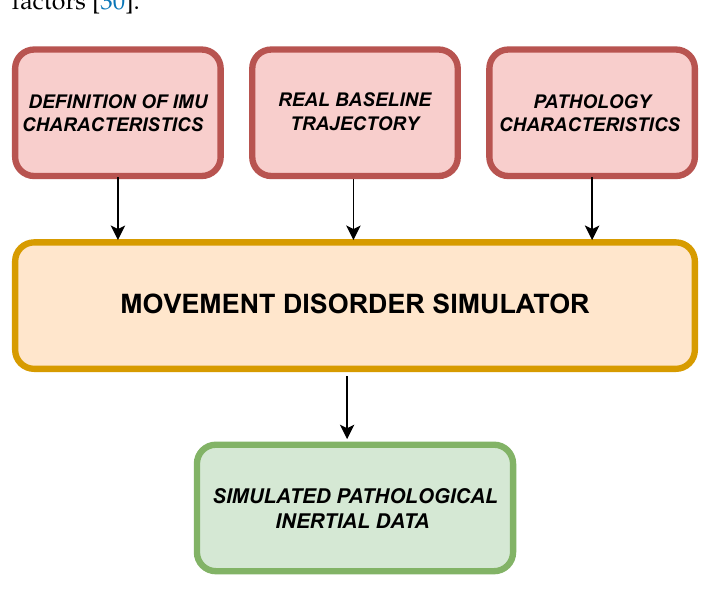
Figure 1. Simulator block